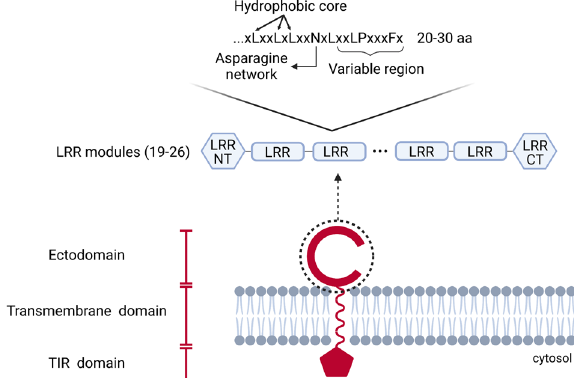
Fig. 1 Schematic overview of the TLR structure. ATLR is composed of: (i) an extracellular ligand-binding domain (ECD) containing various numbers of LRR modules (19 – 26); (ii) a single transmem- brane α -helix domain (TMD); and (iii) a TIR domain responsible for the downstream signaling cascade. In cases of intracellular TLRs, the N-terminal ECD is directed toward the lumen of the intracellular compartments. Each LRR module is 20 – 30 amino acids (aa) in length and has a consensus “ LxxLxLxxNxL ” sequence and a variable region. The consensus sequence, located in the concave surface of the protein, forms parallel β -strands and ligand-binding sites. It contains the hydrophobic core and the asparagine network, which ensure the protein stability. Created with BioRender.com.